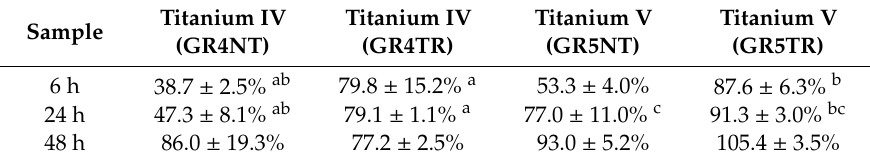
Table 1. Cell viability percentage was calculated regarding control viability (100%) on the various surfaces analysed according to the time slots established.